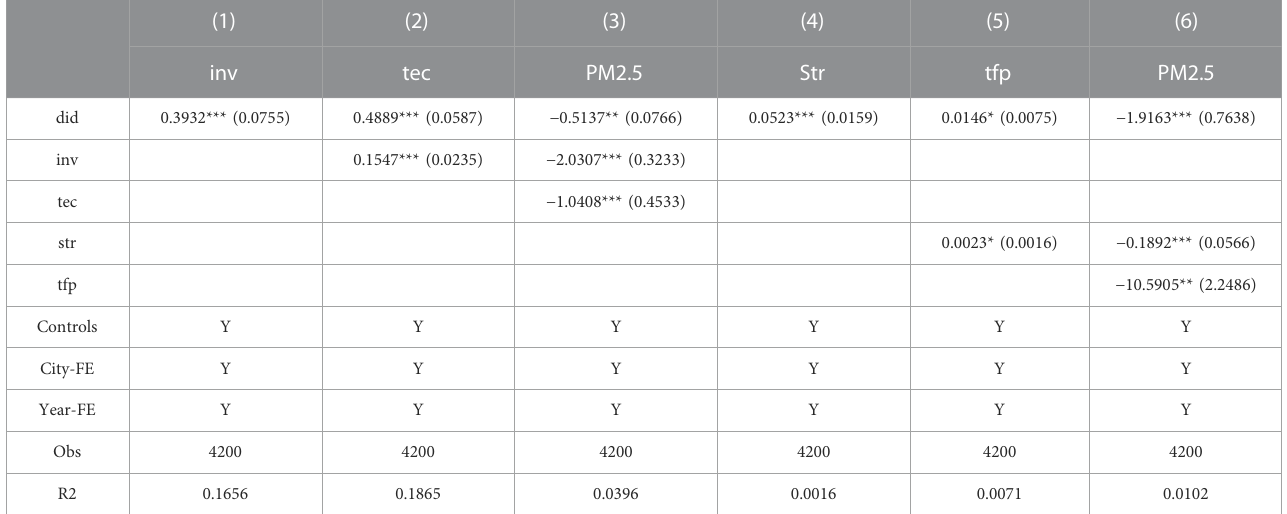
TABLE 6 Mechanism test